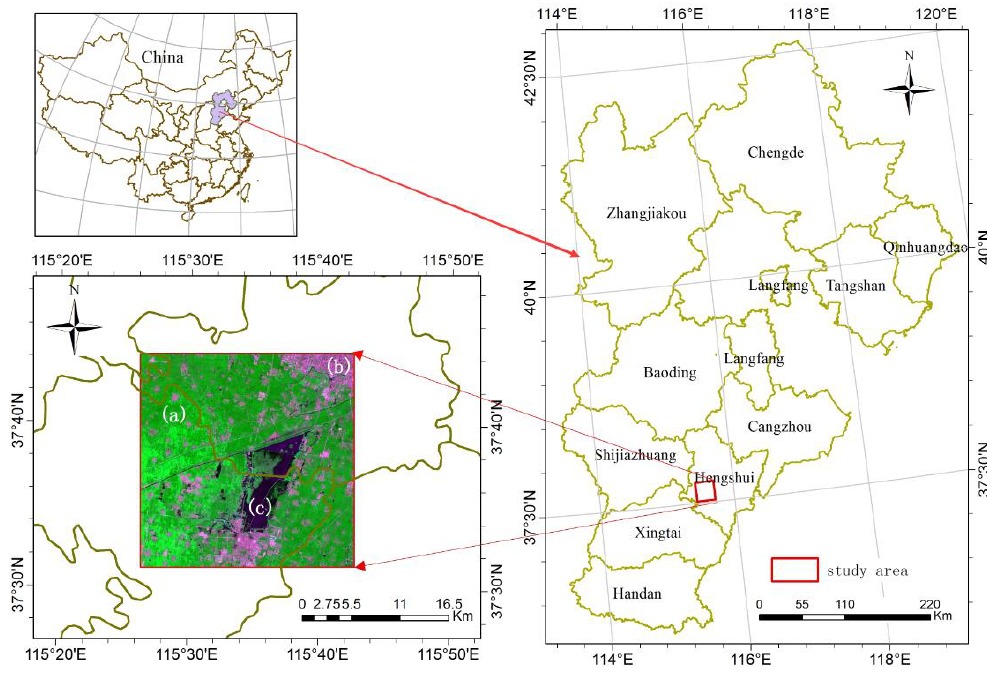
Figure 2. The location of study area.